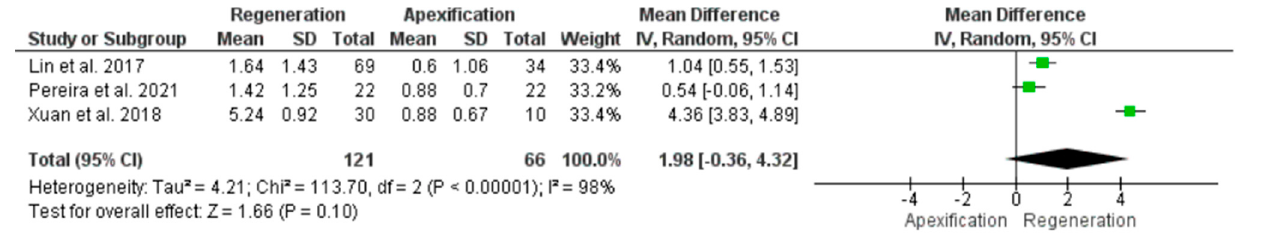
Figure 13. Meta-analysis of increase in root length (IRL) in young immature teeth treated with regenerative endodontic procedure (REP) or apexification procedure.